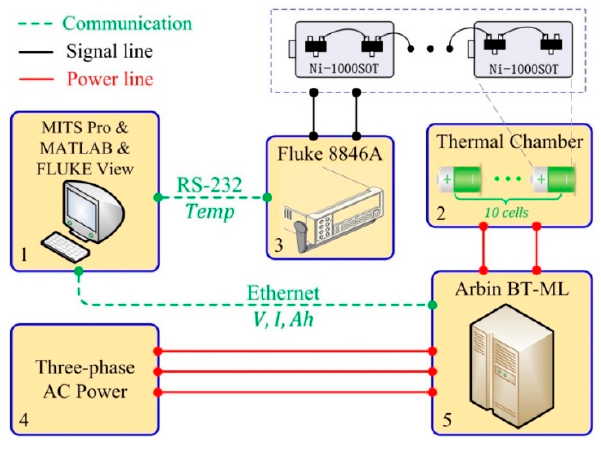
Figure 1. Experimental setup. Table 1. Specifications of the investigated 26650 LiFePO4